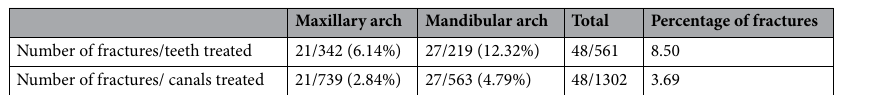
Table 3. Number and percentage of fractures according to the number of teeth and canals treated per